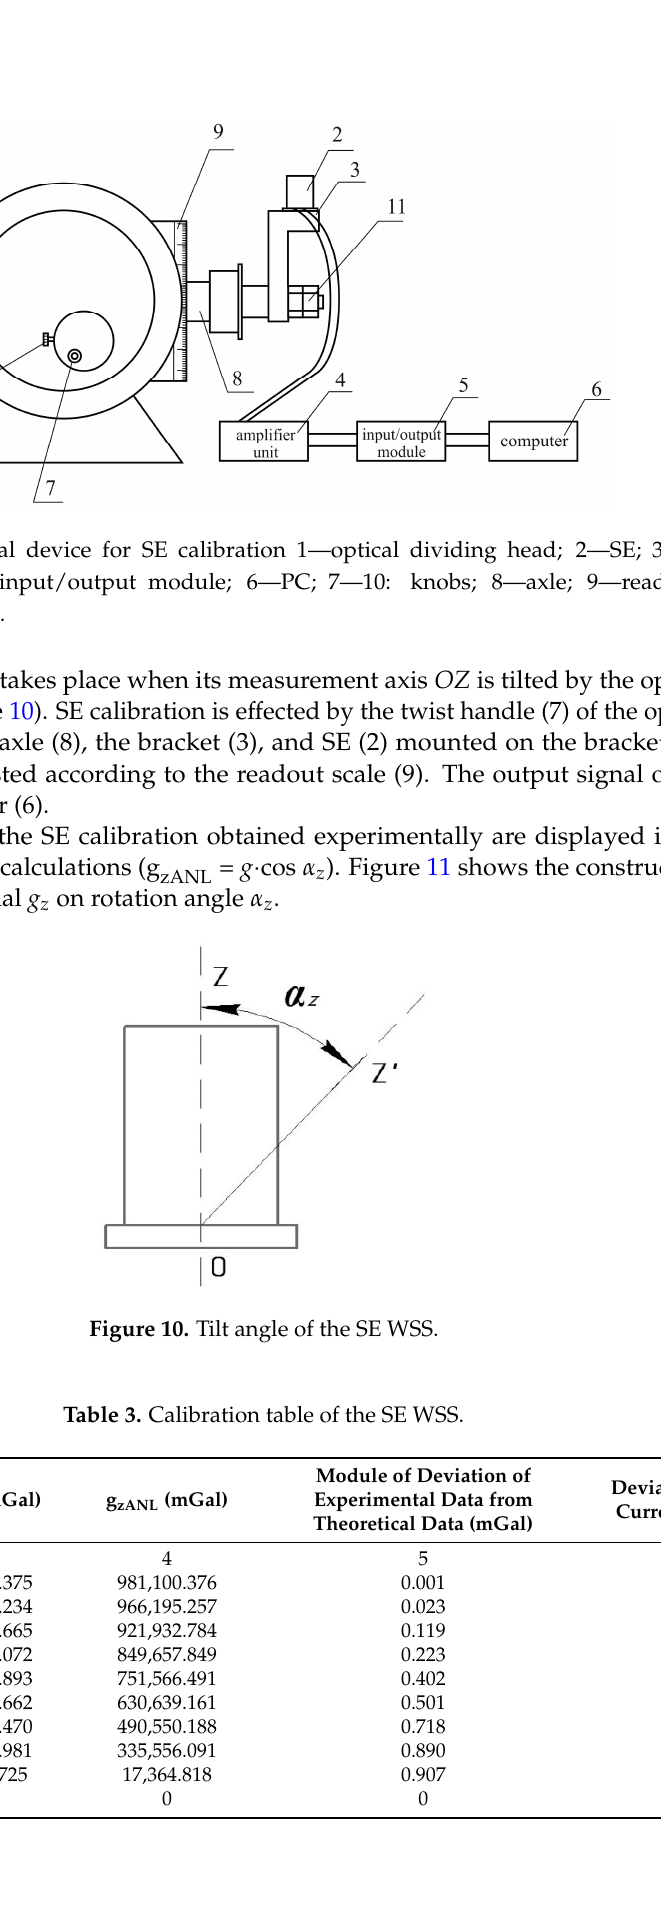
Figure 11. Graph of the dependency of the SE α z measurement axis deviation on the deviation from the current value of the acceleration due to gravity. As can be seen from the Table 3, the difference between deviations of the measurement axis of the automated WSS SE at angle α z , calculated analytically and obtained experimentally, is less than 1 mGal. The angle of rotation of its measurement axis relative to the reference vertical directly affects its initial values and the value of its error. Given that gravimetric measurements are made on the base moving in space, the coincidence of the SE WSS measurement axis with the reference vertical should always be ensured. To put this into